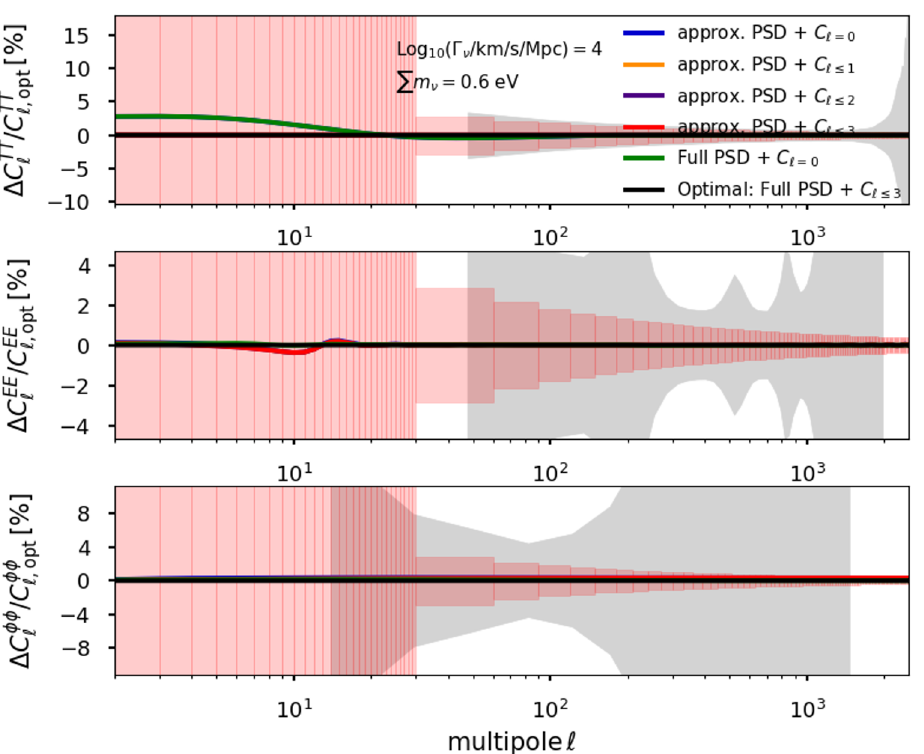
(Γ [km / s / Mpc]) = 4 ), ν / 10 0 . 03 dec /m ν ’